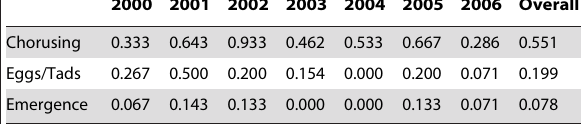
Table 1. Frequency of observed Houston toad ( Bufo houstonensis ) chorusing, eggs or tadpoles, and emergence for each year and across all years for 17 ponds in Bastrop County,